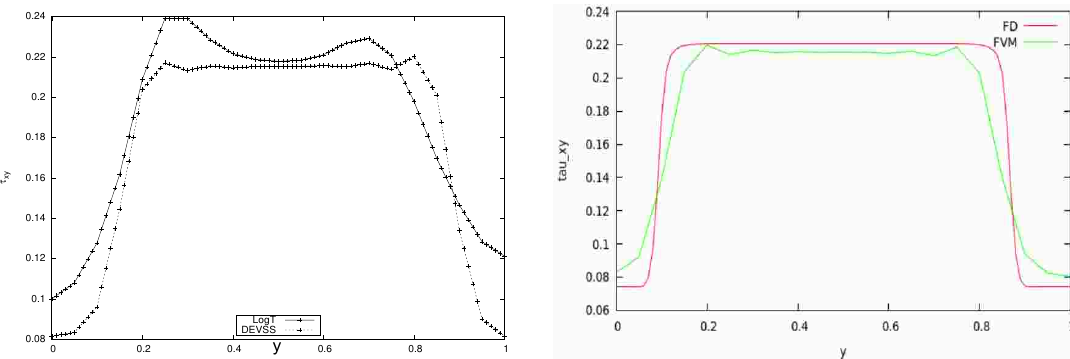
Figure 4. Shear stress profile ( τ xy = σ pxy ) for We = 2, η S = 0.05, η P = 0.95, ξ = 0.8, and Re = 1 for the Johnson-Segalman model (compared with reference [24] (RHS)).